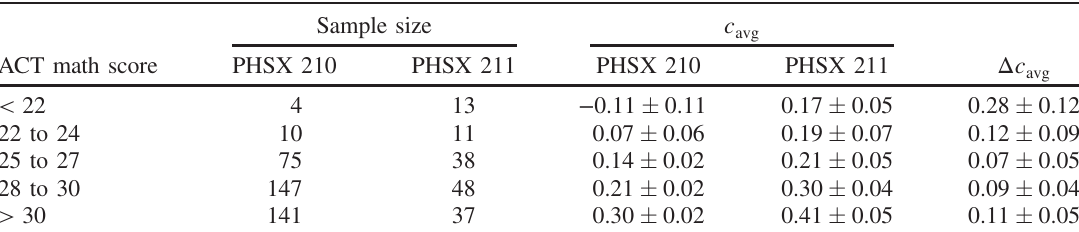
TABLE II. The average normalized change for pretest and post-test FCI scores for students who completed PHSX 210 or PHSX 211 sorted by ACT math scores. The uncertainty corresponds to the 68% confidence interval of the standard